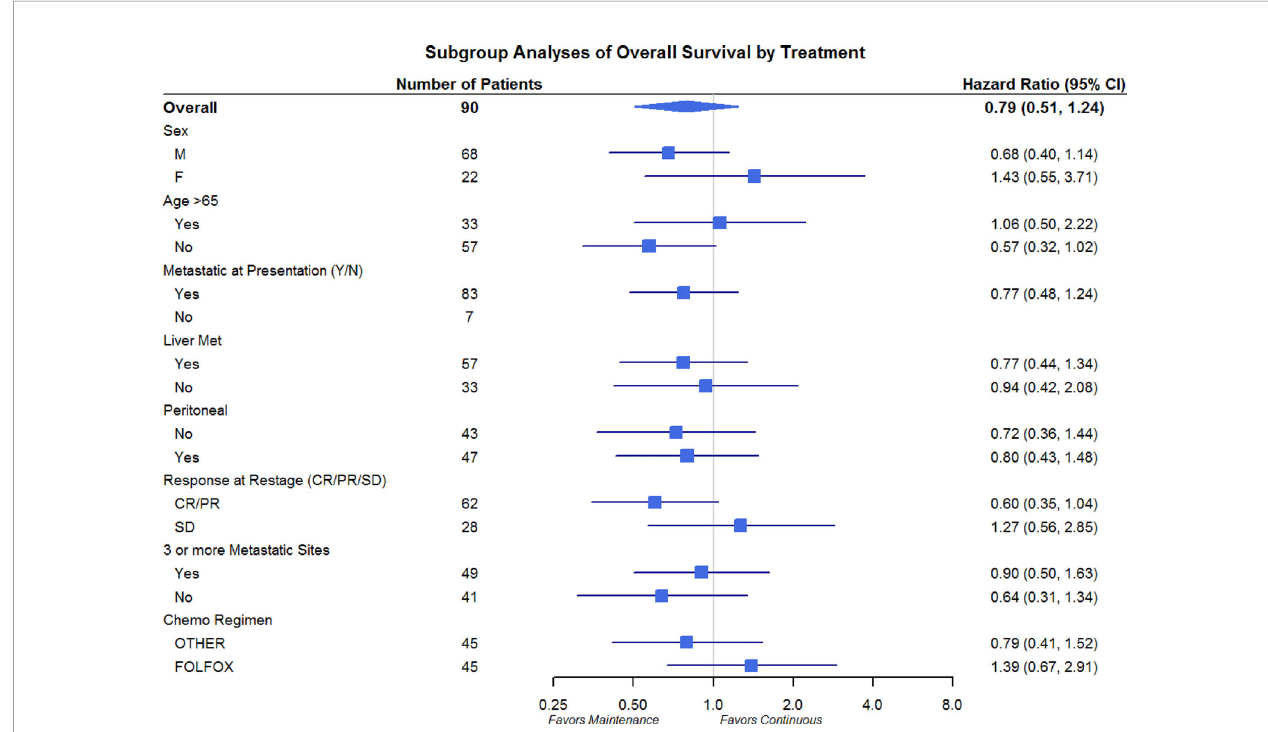
FIGURE 3 | Overall Survival Subgroup Analysis of Gender, Age, Metastatic Site, and Chemo Regimen.